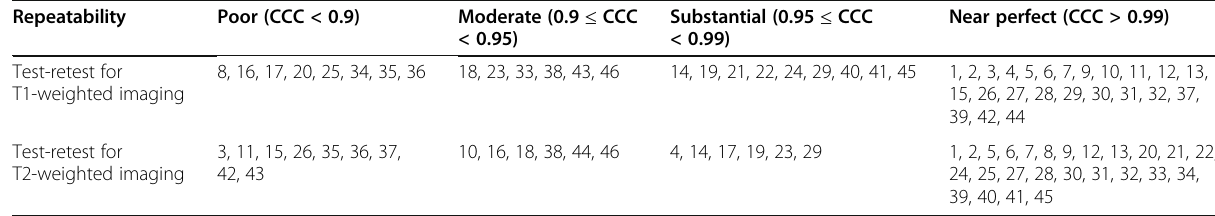
Table 5 Texture features repeatability in the test-retest experiment